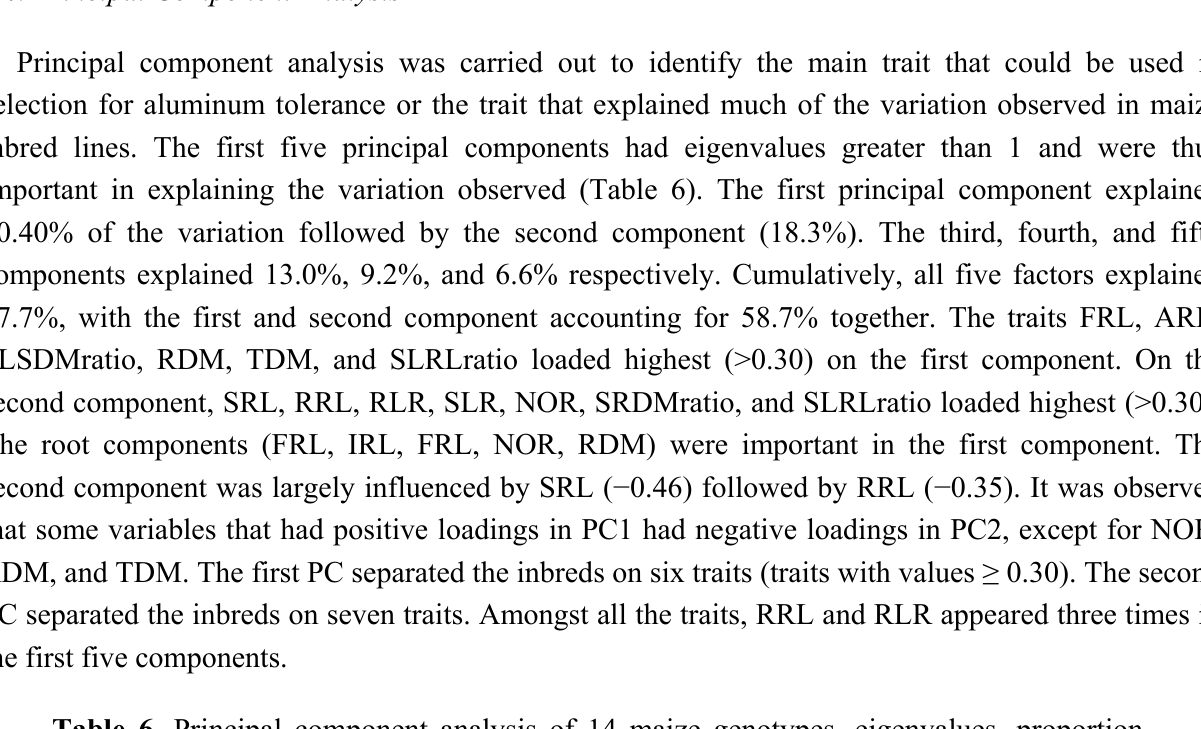
Table 6. Principal component analysis of 14 maize genotypes, eigenvalues, proportion, and cumulative variance for the first six components for root morphological characters in six aluminum concentrations ( n =